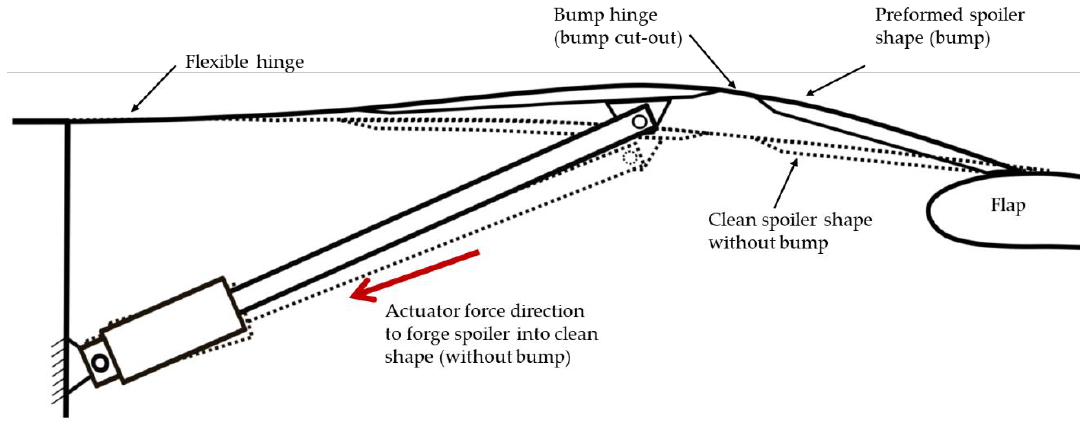
Figure 2. Adaptive spoiler with preformed shape and the spoiler actuator based on [62].